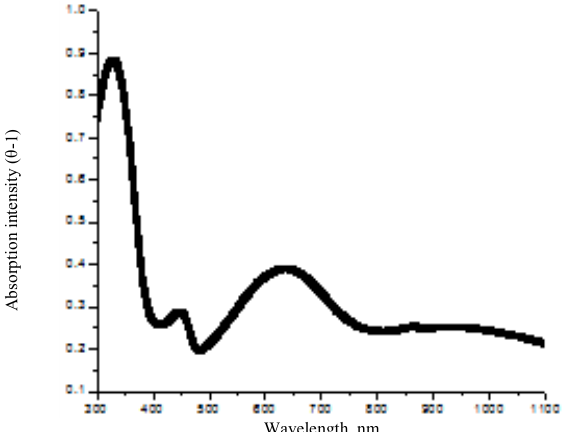
Figure 1. UV-Visible spectrum of BF